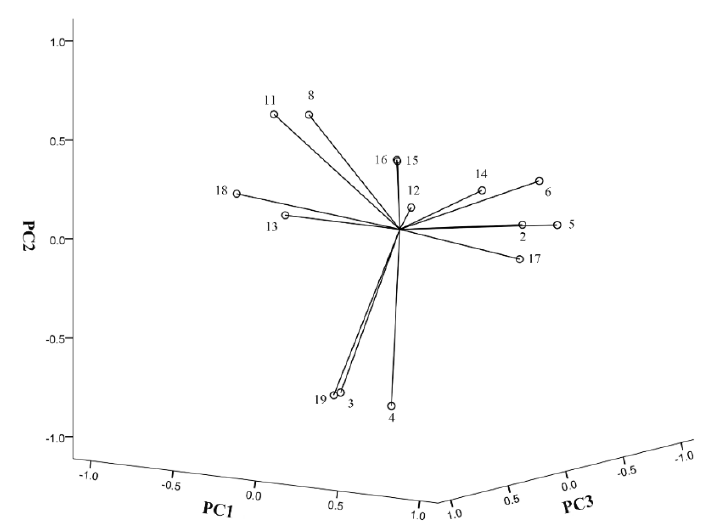
Figure 3. The loadings plots of the principal components. See Table 3 for compound names.